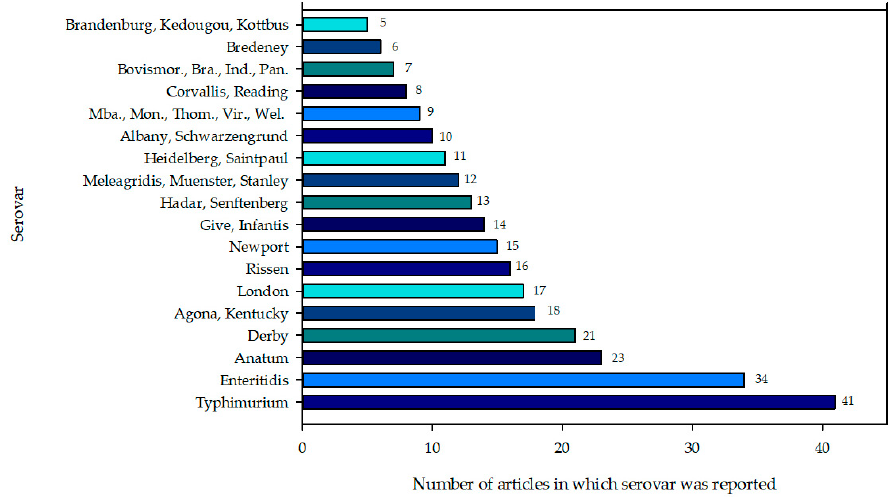
Figure 2. Frequency of serovars described in more than five studies. Abbreviations: Bovismor, Bovismorbificans; Bra, Braenderup; Ind, Indiana; Pan, Panama; Mba, Mbandaka; Mon, Montevideo; Thom, Thompson; Vir, Virchow; Wel, Weltevreden.